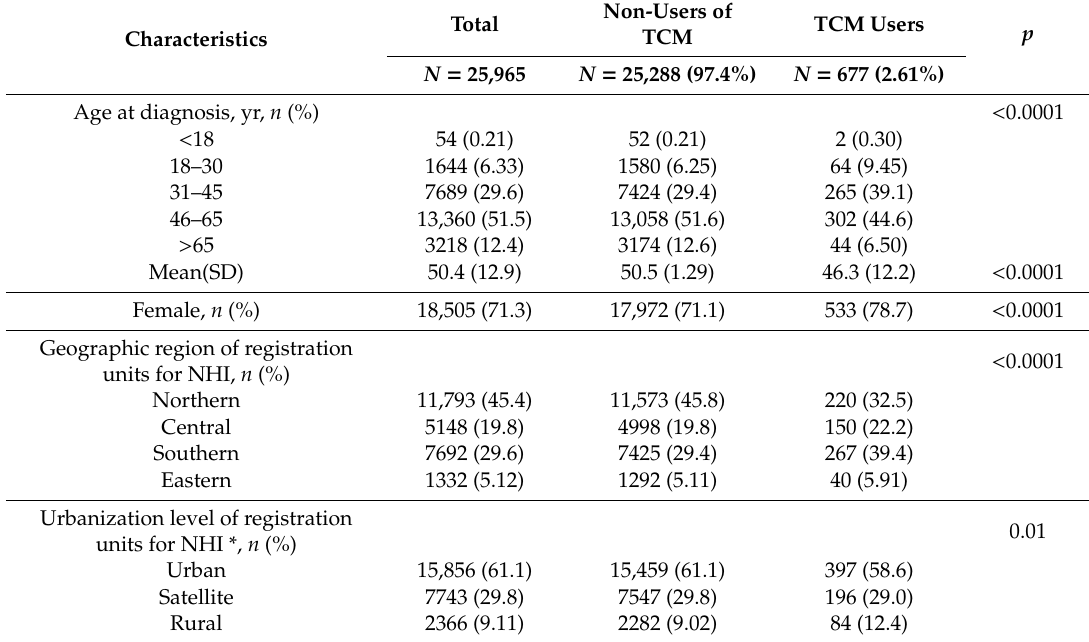
Table 1. Baseline characteristics of patients with and without TCM use as the preferred medical care for carpal tunnel syndrome at